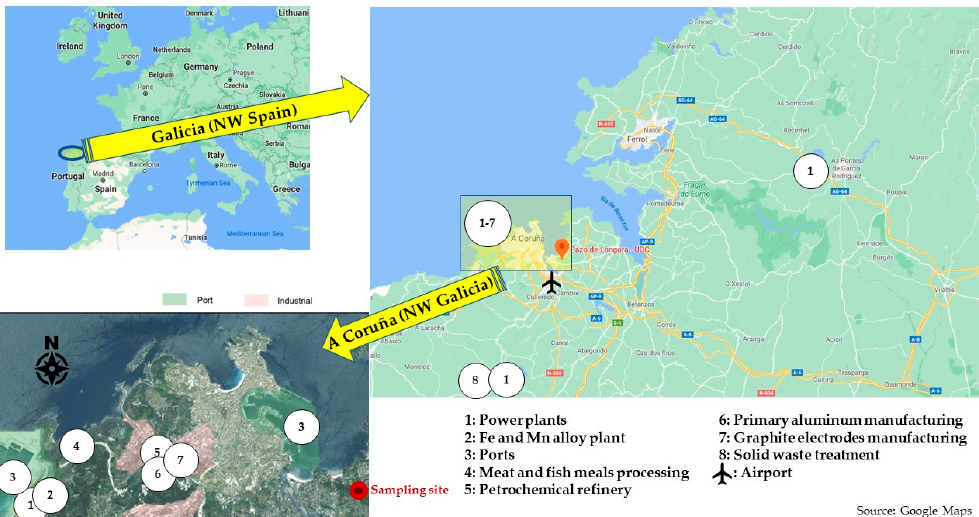
Figure 1. Map of the sampling site showing relevant issues. The prevailing wind direction in Galicia is northeast (NE) in summer and southwest (SW) in winter. The local wind pattern in the sampling site is mainly conditioned by the land–sea breeze because of its proximity to the sea (1 km). Northwest (NW) winds are dominant, although other wind directions are also recorded, and generally carry in relatively clean air from the sea. However, the main industrial sources (including A Coruña city) are located in this